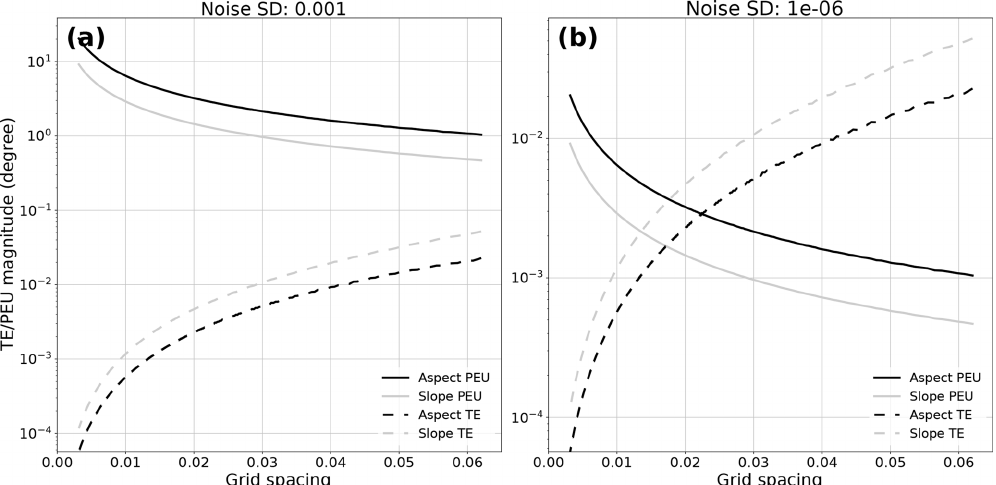
Figure 5. TE and PEU magnitudes for two noise levels, (a) 1 e − 4 and (b) 1 e − 6 , compared to grid spacing. Aspect is plotted in black; slope is plotted in gray. Solid lines are used for PEU; dashed lines are used for TE. TE decreases with decreasing grid spacing, while PEU increases as the noise standard deviation relative to grid spacing increases.